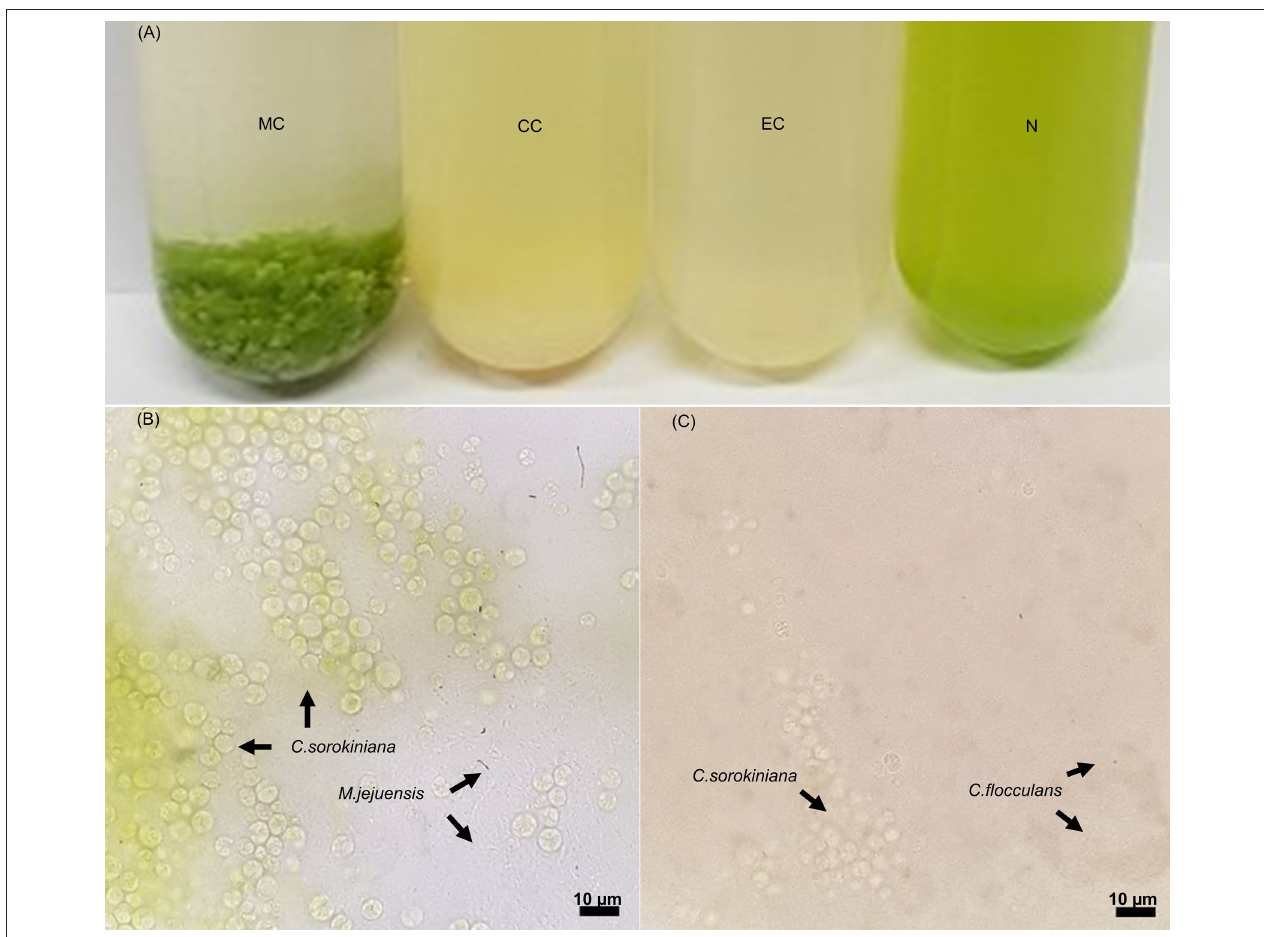
FIGURE 1 | Images of cultures and light microscopy images of floc. In co-culturing conditions (A) , floc was formed in the MC and CC conditions, but no floc was observed in the EC and N conditions. The floc formed in the MC (B) and CC (C) conditions contained bacteria and algae (scale bar, 10 µ m). The location of each species is marked with an arrow. MC, M. jejuensis and C. sorokiniana ; CC, C. flocculans and C. sorokiniana ; EC, E. coli and C. sorokiniana ; N, C. sorokiniana only, control group. Marked characteristics are annotated in Supplementary Figure 1